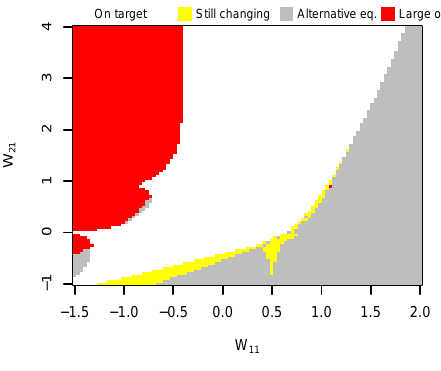
Figure SI4 – Reasons for not reaching the desired equilibrium. Although equation 4 guar- antees that an equilibrium exists at the target phenotypic expression, the equilibrium might not be reachable in practice when simulating the gene network dynamics. The col- ored area in the figure corresponds to networks that failed to produced the target phe- notype, each color representing a distinct reason; Yellow: network dynamics was slow and the final gene expression has not been reached yet after 16 time steps; Gray: an al- ternative equilibrium was reached (most of the time implying that one or both genes are either completely silenced to fully expressed). Red: The network steady state featured oscillations that were so large that they hit the maximum or minimum expression, shifting the average expression away from the target